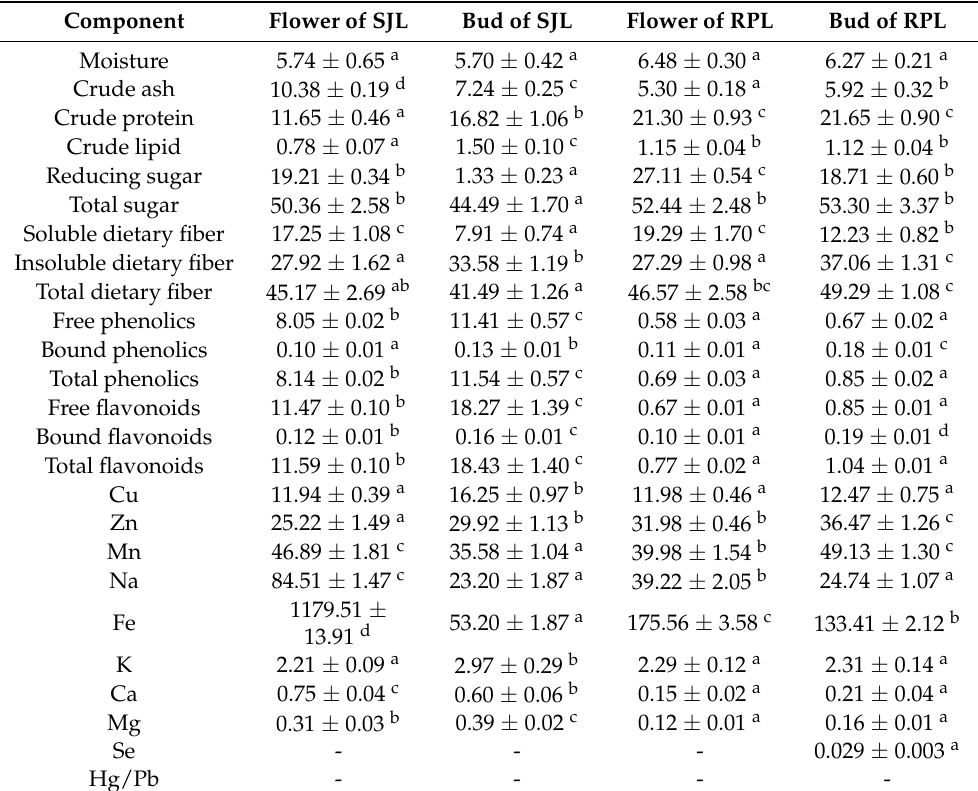
Table 1. Proximate chemical composition (g/100 g dw), mineral and metal (mg/kg dw) contents of SJL and RPL. Component Flower of SJL Bud of SJL Flower of RPL